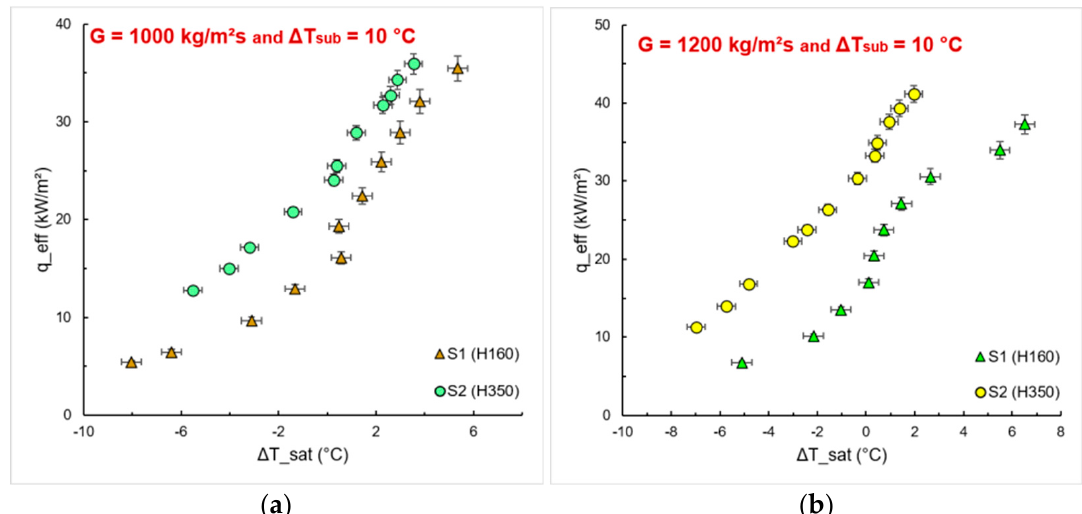
Figure 9. E ff ect of pin fi n height on fl ow boiling heat transfer of HFE-7100 for Δ T sub = 10 °C. ( a ) G = Figure 9. Effect of pin fin height on flow boiling heat transfer of HFE-7100 for ∆ T sub = 10 ◦ C. 1000 kg/m 2 s; ( b ) G = 1200 kg/m 2 s.